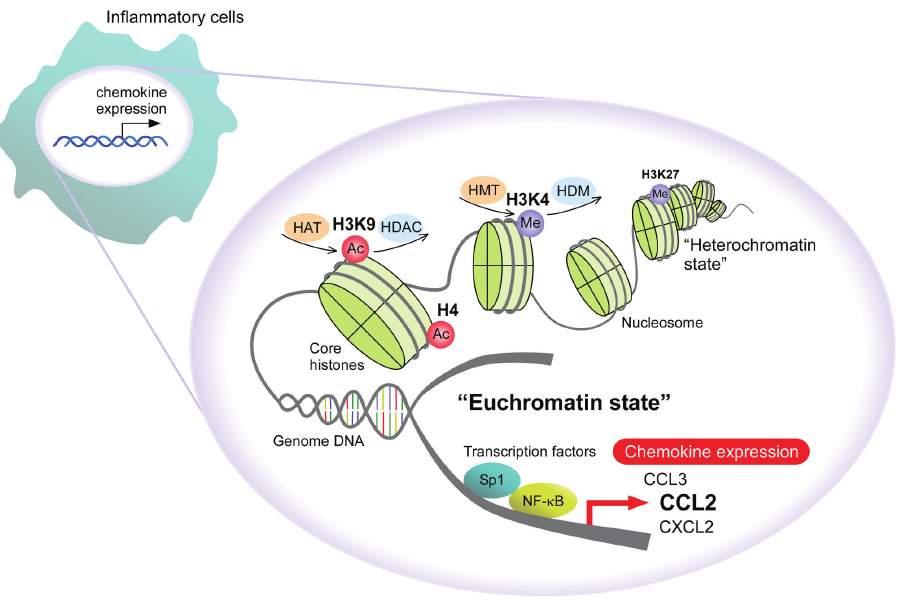
Figure 1 Epigenetic mechanisms regulating chemokine